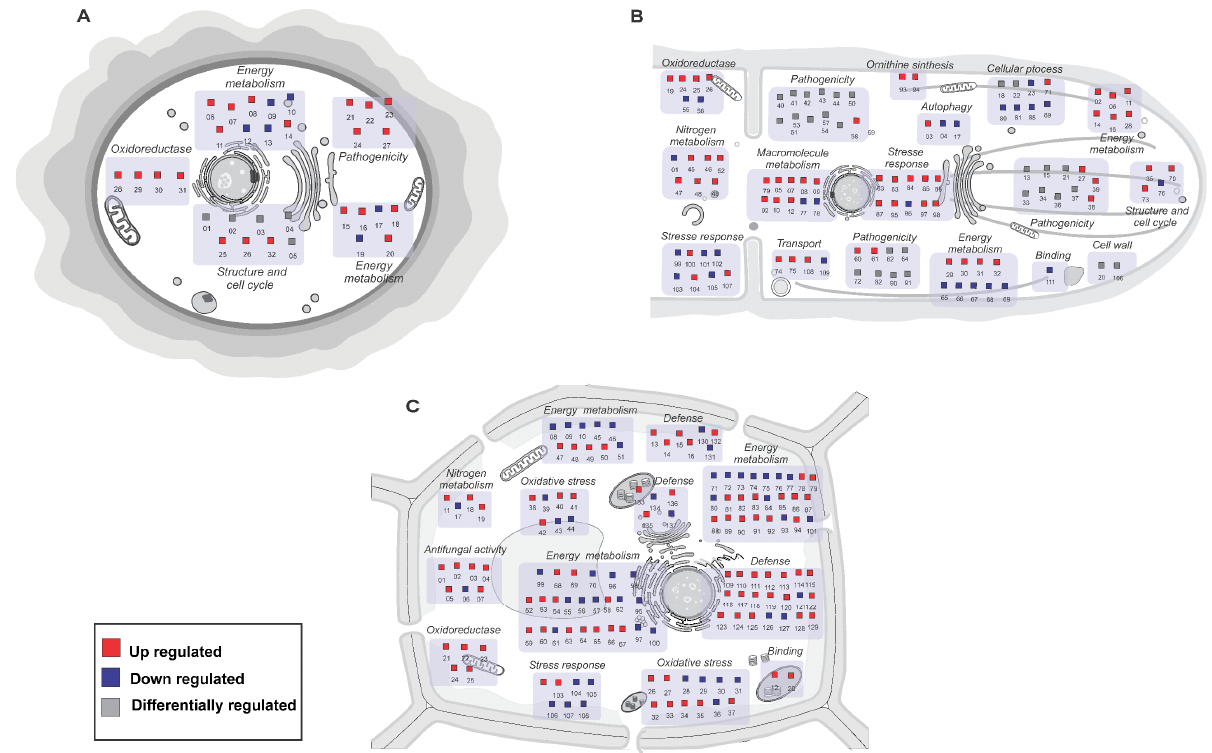
Figure 6. Identified proteins with differential regulation in studies that have used proteomics as an analytic strategy: ( A ) proteins differentially regulated identified in M. perniciosa spores; ( B ) proteins differentially regulated identified in the mycelium of M. perniciosa ; and ( C ) proteins differentially regulated in the host Theobroma cacao when infected by M. perniciosa . Proteins are grouped according to their biological functions. The numbers represent identification of proteins shown in Supplementary Table S5. Differential regulated: in the different experimental conditions of the analyzed studies.